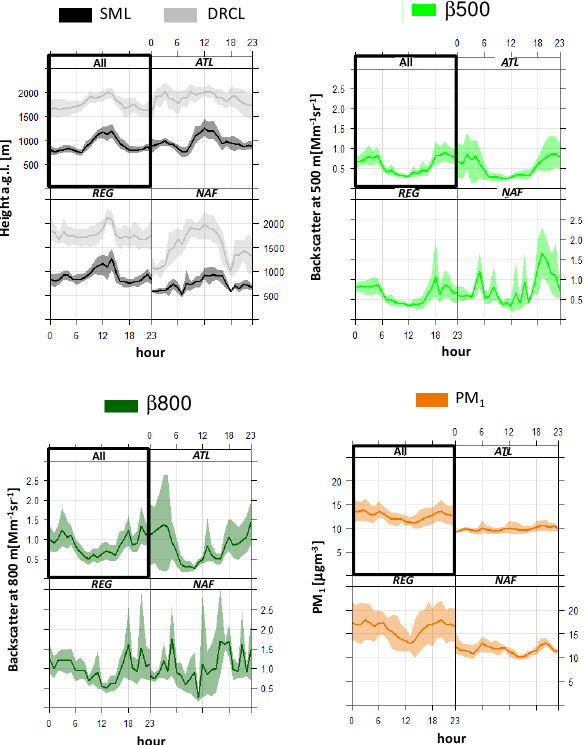
Fig. 1b. Diurnal cycles of ground temperature ( T ) [ ◦ C], relative humidity (RH) [%], and wind speed [ms − 1 ] calculated for the en- tire SAPUSS campaign (All) and for the ATL, REG, and NAF